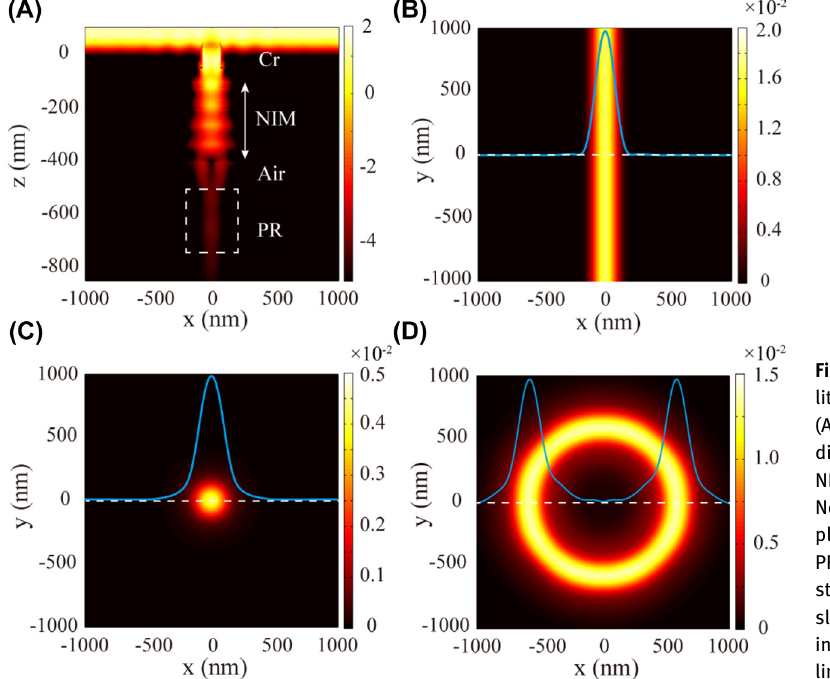
Figure 3: Simulated results of the NIM-based lithography. (A) Cross section of normalized intensity distribution in logarithm scale inside the NIM-based lithography design. (B – D) Normalized intensity distributions in x – y plane extracted from the middle position of PR. The corresponding mask patterns are straight slit, isolated aperture, and annular slit, respectively. The insets show the related intensity distributions along the dashed lines.